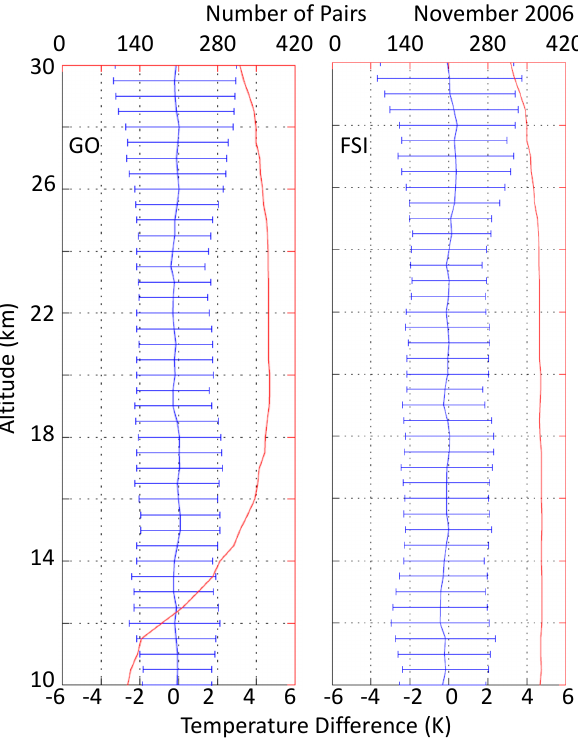
Fig. 4. Comparisons between COSMIC GPS RO profiles and high-resolution routine radiosonde data in November 2006 in North America. The blue lines show the temperature differences and stan- dard deviations (bottom scale), where the GO and FSI methods are adopted for GPS RO retrieval in left and right panels, respectively. The red lines indicate the number of pairs for comparisons (top